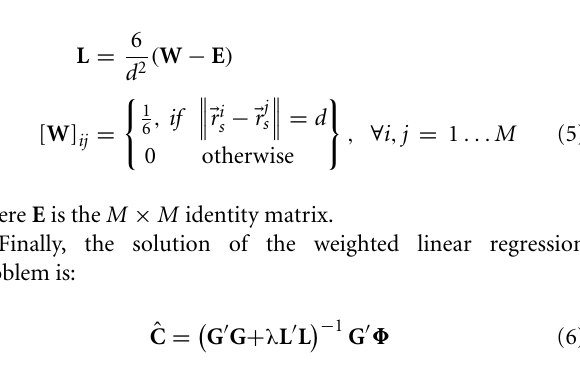
shown (C) . Each grid point has a vCSD value C j , ( j = 1 , 2 , ··· , M ) and the electric potential observed at the i th microelectrode is denoted by φ i , ( i = 1 , 2 , ··· , N ) . (D) The spherical inhomogeneous and anisotropic (SphIh) volume conductor model. Six concentric spherical shells represent the layers of the somatosensory cortex, and each shell has particular radial and tangential conductivity values (Goto et al.,